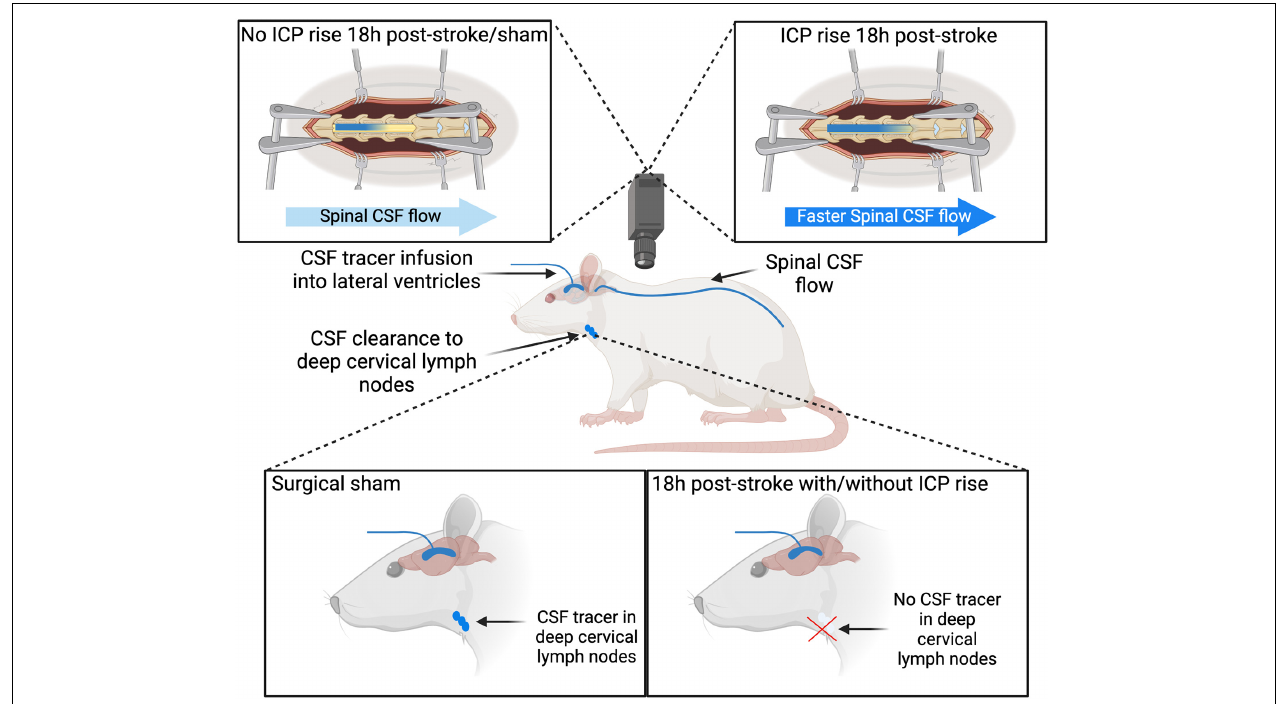
FIGURE 7 | Cerebrospinal fluid (CSF) tracer movement into the deep cervical lymph nodes and spinal CSF space. Stroke animals have impaired CSF clearance to deep cervical lymph nodes 18 h post-stroke with and without intracranial pressure (ICP) rise. Increased ICP 18 h post-stroke is associated with faster CSF tracer movement into the spinal CSF space, compared to stroke animals without ICP rise and sham